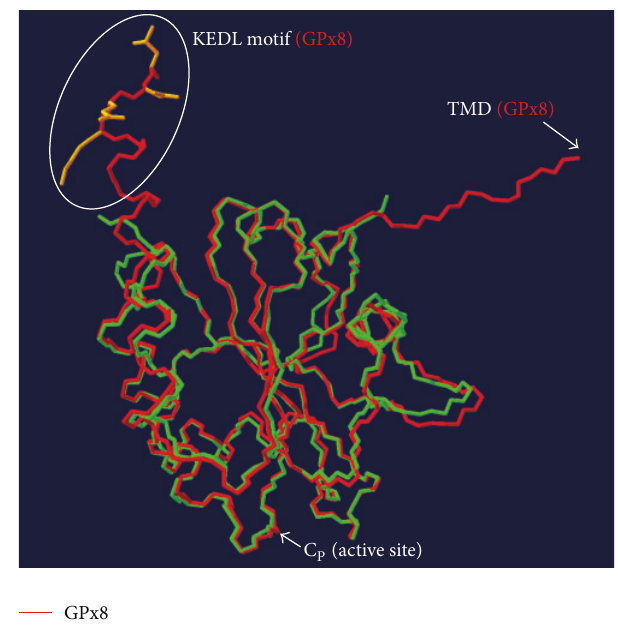
Figure 3: Superimposition of GPx7 and GPx8. Overlay of the carbon-nitrogenbackbonesofGPx7(green;PDBID2KIJ)andGPx8 (red; PDB ID 2P31) was done using the Swiss PDB viewer software (available at http://www.expasy.org/). The close resemblance of the two three-dimensional structures is particularly appreciable in the peptide loops surrounding the active site Cys (C P ). The ESP reten- tion signal (KEDL motif) and the location of the transmembrane domain (TMD) of GPx8 (not part of the crystal structure) are